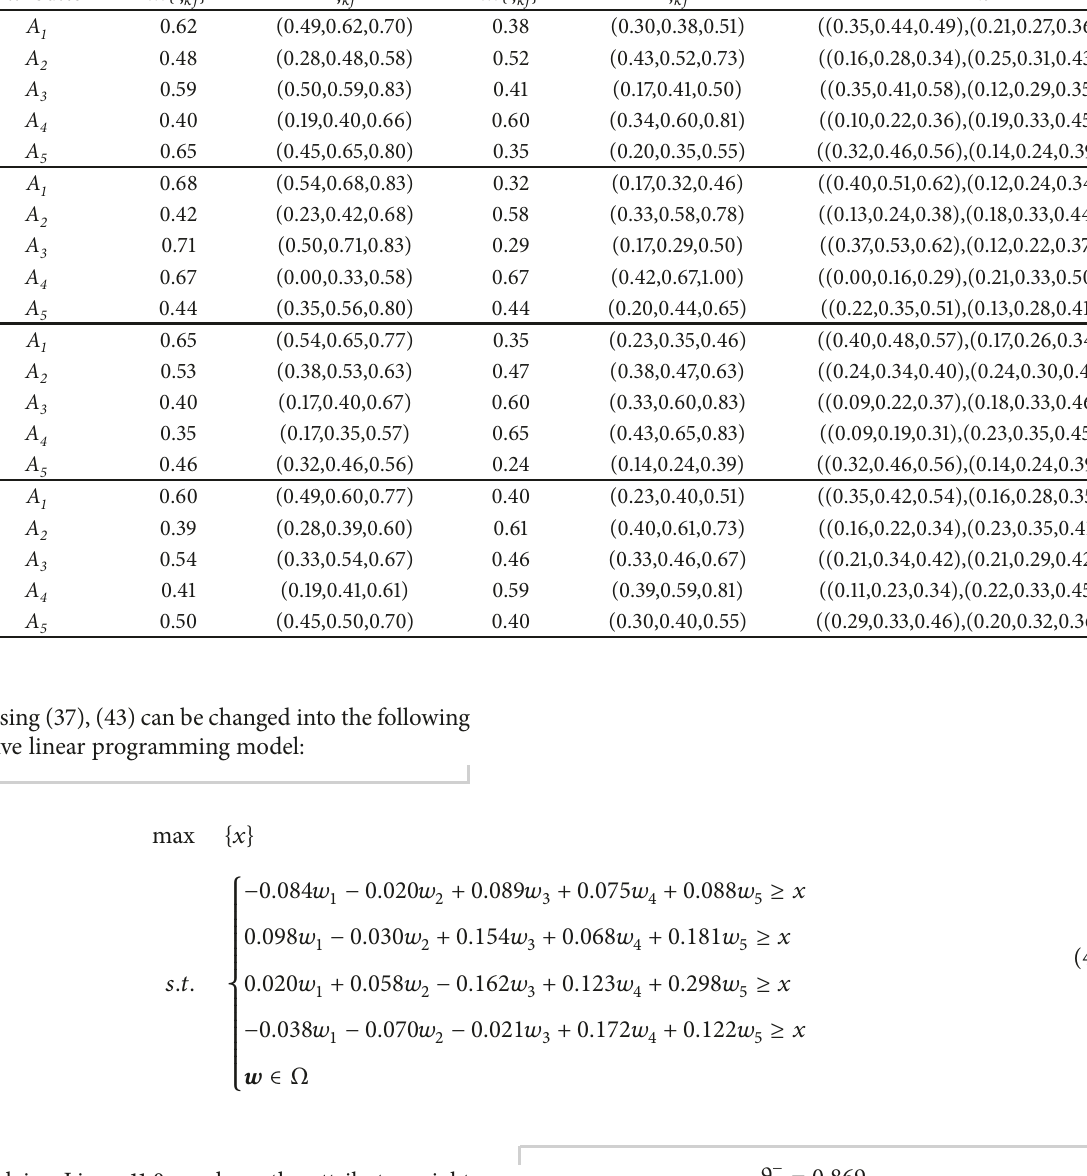
Table 3: Mode 𝑚{𝜉 𝑘𝑗 } , 𝑚{𝜁 𝑘𝑗 } , Qst 𝛿 𝑘𝑗 , Qdt 𝛾 𝑘𝑗 and aggregated ITFNs of attribute vectors.